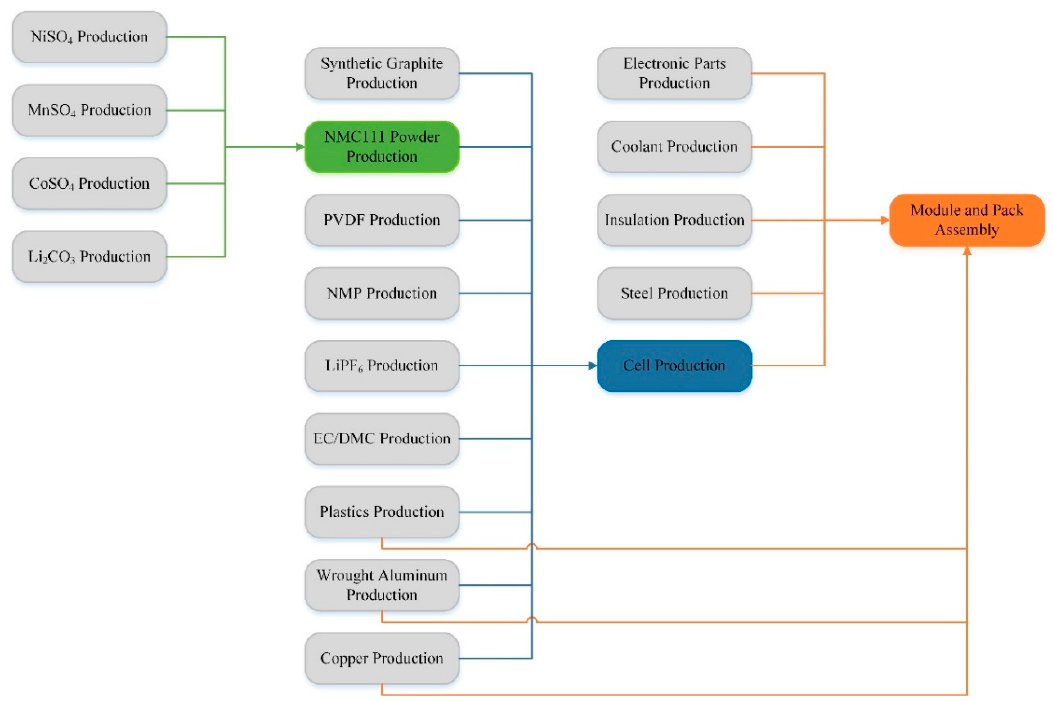
Figure 1. Cradle-to-gate system boundary of LiNi 1/3 Mn 1/3 Co 1/3 O 2 (NMC111) battery production.